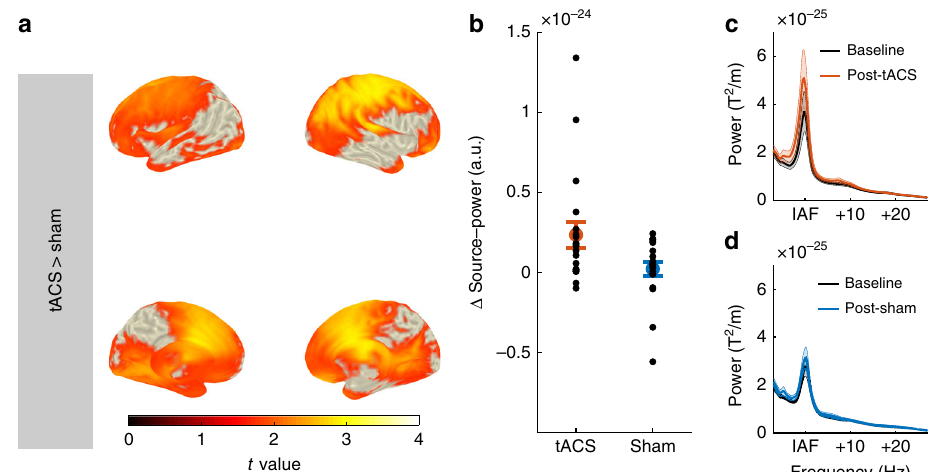
Fig. 3 Effect of tACS on source-level α -power. a Statistical map contrasting the power increase from the pre- to the post-stimulation block between experimental conditions (tACS vs. sham). Statistical map shows t values, thresholded at an α -level of 0.05. b Power increase within the cluster for each of the experimental groups. Black dots represent the power increase of each individual subjects in the experimental groups. c Power spectra before and after tACS (average over all gradiometer sensors and participants). All spectra were aligned to participants ’ individual α -frequency (IAF) before averaging. d Power spectra before and after sham stimulation. Error bars and shaded areas depict standard error of the mean (S.E.M.). Source data are provided as a Source Data fi le.